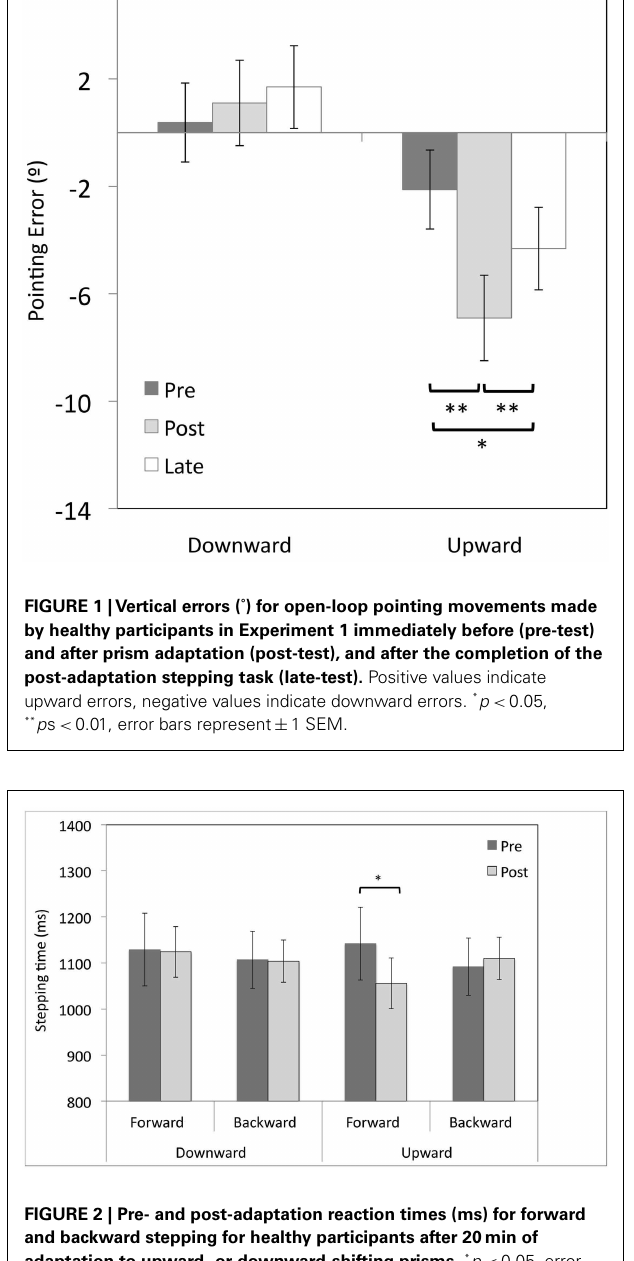
times were unchanged by adaptation to either upward- or downward-shifting prisms ( p s > 0.05).